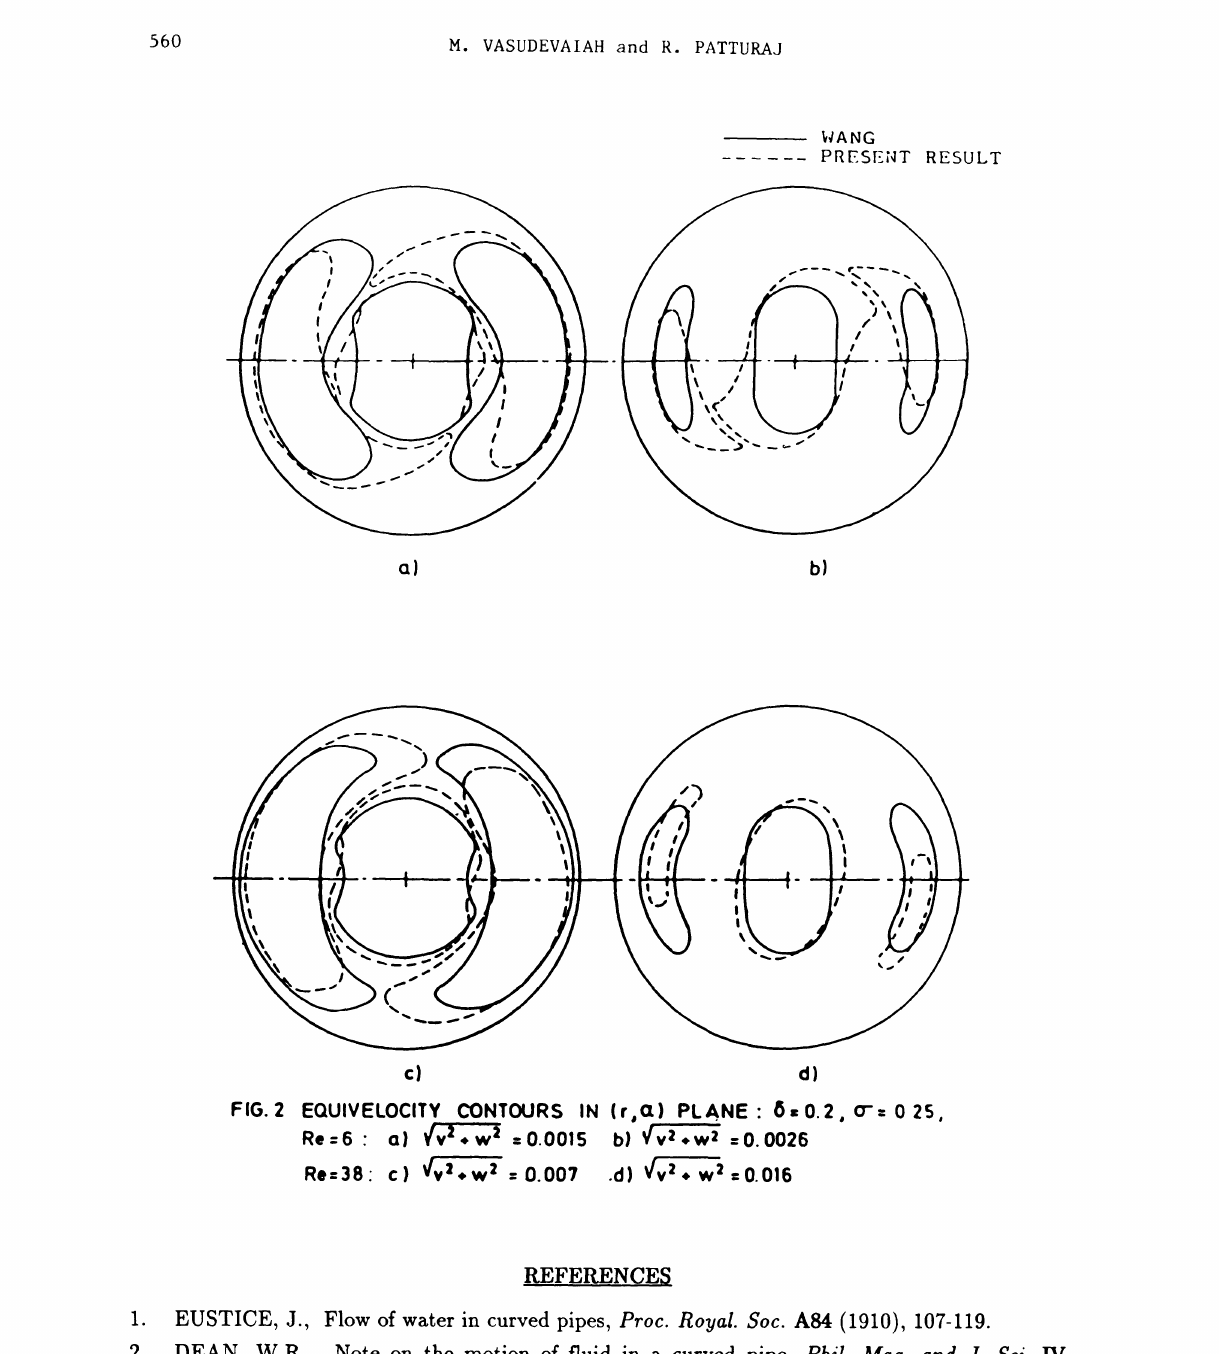
FIG. 2 EQUIVELOCITY CONTOURS IN (r,O,) PLANE 8 0.2, ow Re=6 a) tfv 0.0015 b) Vvo$ =0.0026 Re=38: c) /v.w